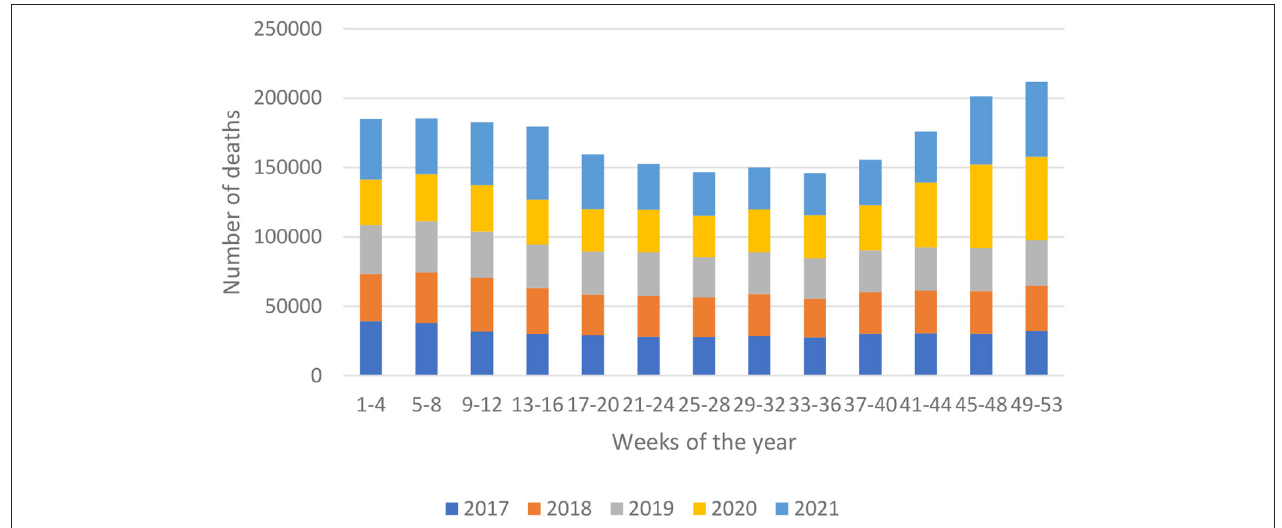
FIGURE 1 | The total number of deaths by weeks in Poland in 2017–2021. Own study based on: https://dane.gov.pl/pl/dataset/1953/liczba-zgonow- zarejestrowanych-w-rejestrze-stanu-cywilnego.